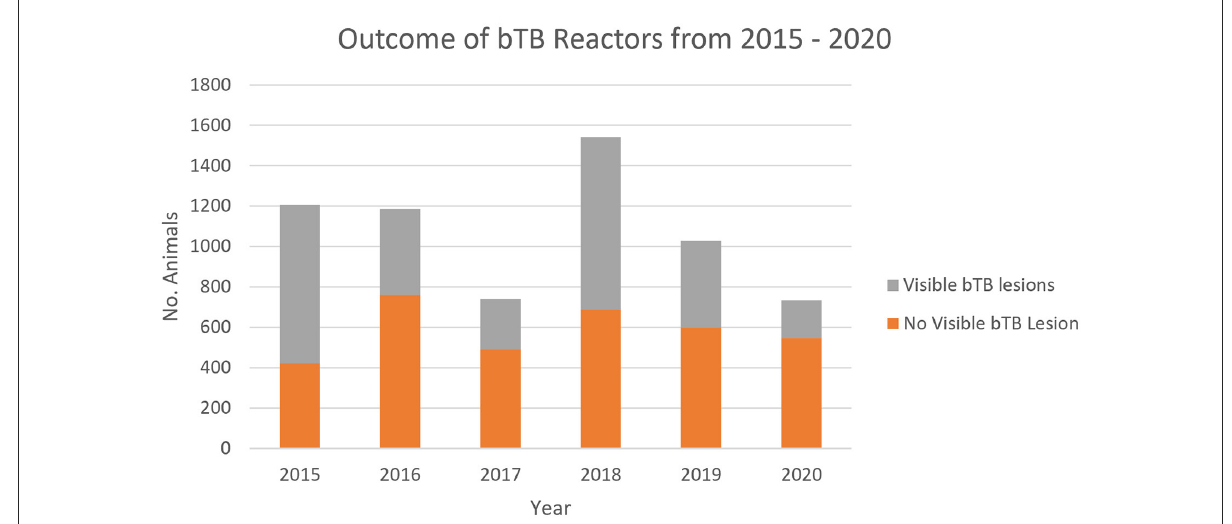
FIGURE6 Post-mortem designation of all reactor animals sent to FMIB Nasinu abattoir.